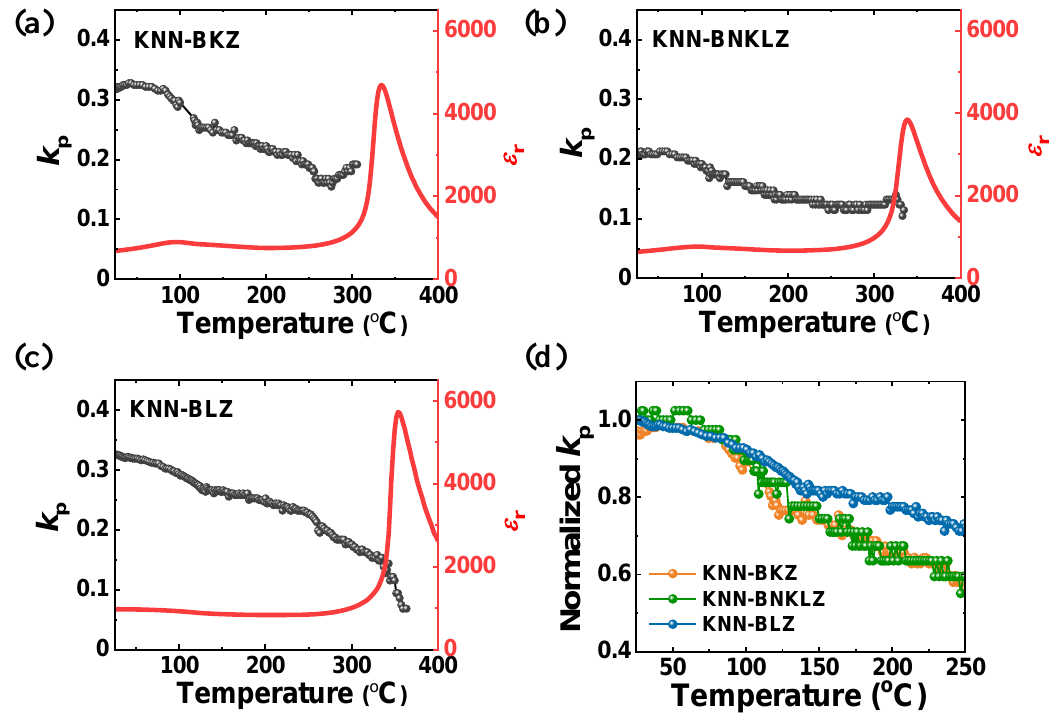
Figure 1. Temperature dependence of k p and ε r for: ( a ) KNN-BKZ; ( b ) KNN-BNKLZ; and ( c ) KNN-BLZ ceramics and ( d ) Normalized value of k p with temperature variation.